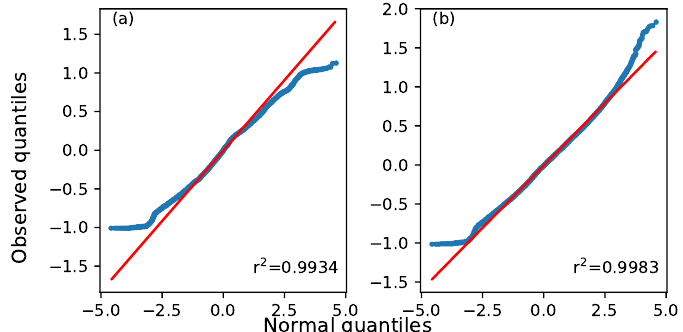
Figure 17. Quantile-quantile plot of relative hourly emission data with squared correlation coefficient r 2 . Red line shows the expected distribution if the residuals are perfectly normally distributed. ( a ) Relative emissions with no hourly factor adjustment. ( b ) Relative emissions with hourly and weekly cycles